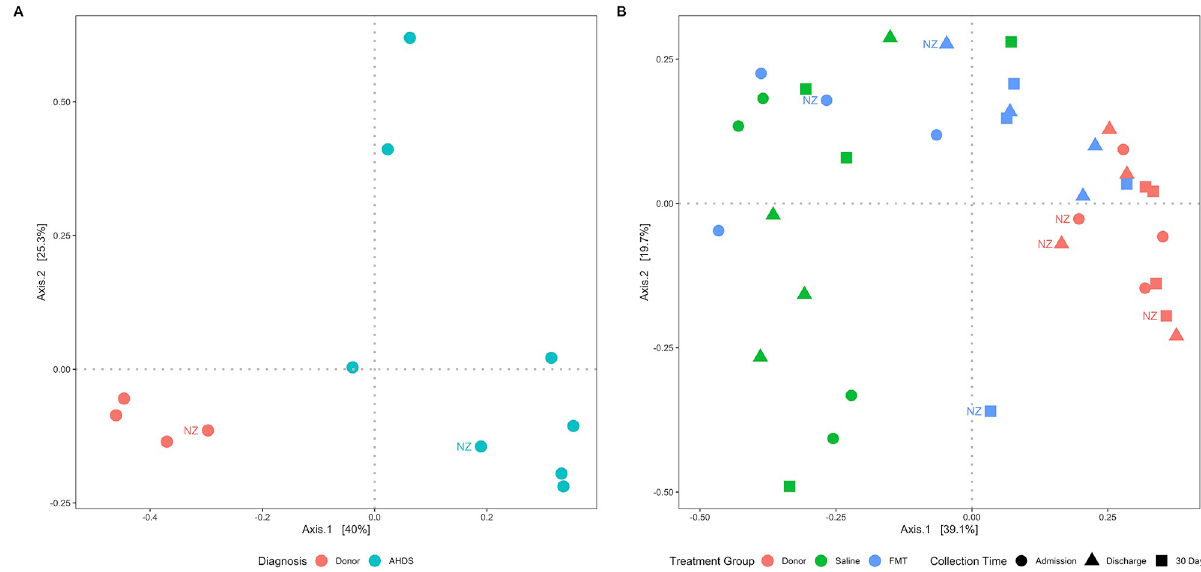
Fig 4. Principal coordinate analysis of the Bray Curtis dissimilarity matrix reveals changes in community composition associated with FMT. The Bray-Curtis dissimilarity was visualized using principal coordinate analysis (PCoA) and compared using permutational analysis of variance (PERMANOVA). (A) Dogs with AHDS separate significantly (P = 0.003) from healthy controls at the time of hospital admission (pre-FMT) along the first principal coordinate (x-axis). (B) Dogs treated with FMT separate from sham-treated controls and pre-treatment samples (circles) at discharge (triangles) and 30 days (squares) and cluster closer to the donor dogs along the first principal coordinate. Separation of groups based on treatment group (P = 0.003) and collection time (P = 0.049) were significant. AHDS: acute hemorrhagic diarrhea syndrome; FMT: fecal microbial transplantation; NZ: New Zealand dogs.